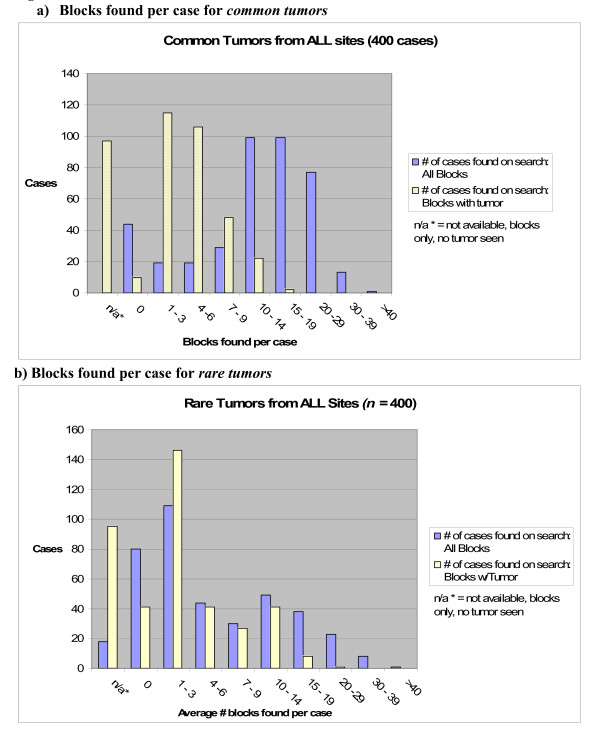
Average blocks found per case from tissue archives. Illustration of the availability of the cases found by all SPIN sites involving the search for (a) the common tumor type and (b) the rare tumor type categories. The breakdown of the average number of all blocks found per case after the initial search from the archives are compared to the number of blocks found with presence of tumor.